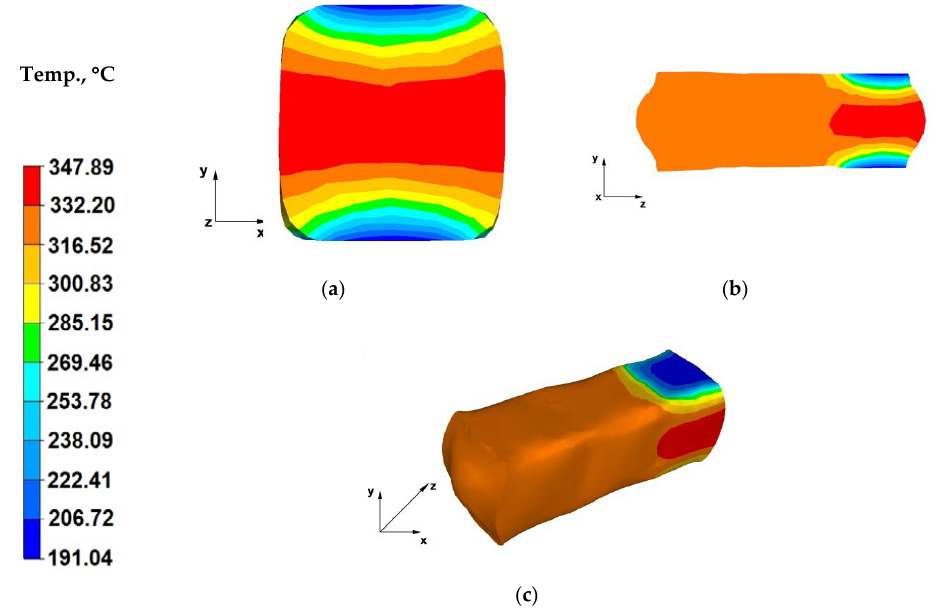
Figure 10. ( a ) Temperature distribution over the cross-section of an AZ91 alloy forging deformed within the sixth pass, with a relative reduction of 40%, in flat dies, after a 90 ◦ turning of the forging; ( b ) Temperature distribution over the longitudinal section of an AZ91 alloy forging deformed within the sixth pass, with a relative reduction of 40%, in flat dies, after a 90 ◦ turning of the forging; ( c ) Axonometric view of the temperature distribution over the surface of an AZ91 alloy forged within the sixth forging pass, with a relative reduction of 40%, in flat dies, after a 90° turning of the forging. of shaped dies was lower compared to the temperature drops of the alloy strained using flat dies (Figure